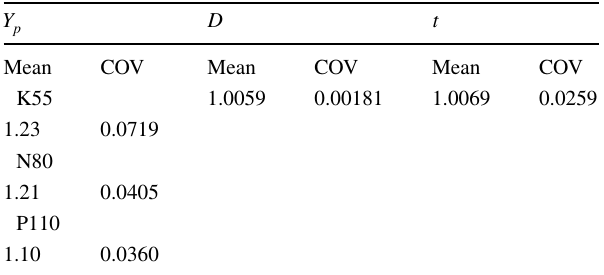
Table 1 Statistical parameters adopted for the random variables